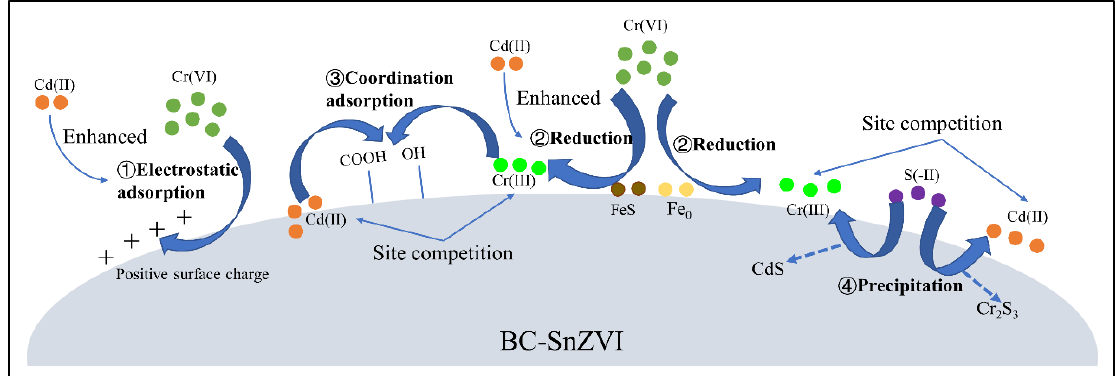
Figure 9. The co-removal mechanism of Cd(II) and Cr(VI) by BC-SnZVI.